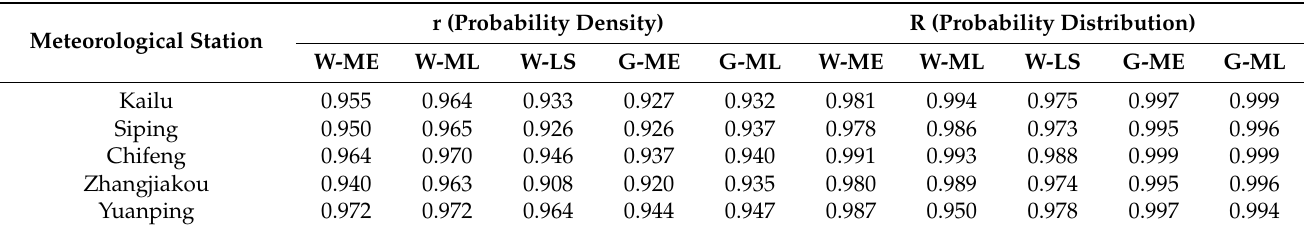
(Table 2). Although meteorological stations with different annual average precipitation lev- els were selected, the accuracy did not show a different rule caused by precipitation levels. Table 2. Accuracy evaluation of probability density and probability distribution for precipitation.